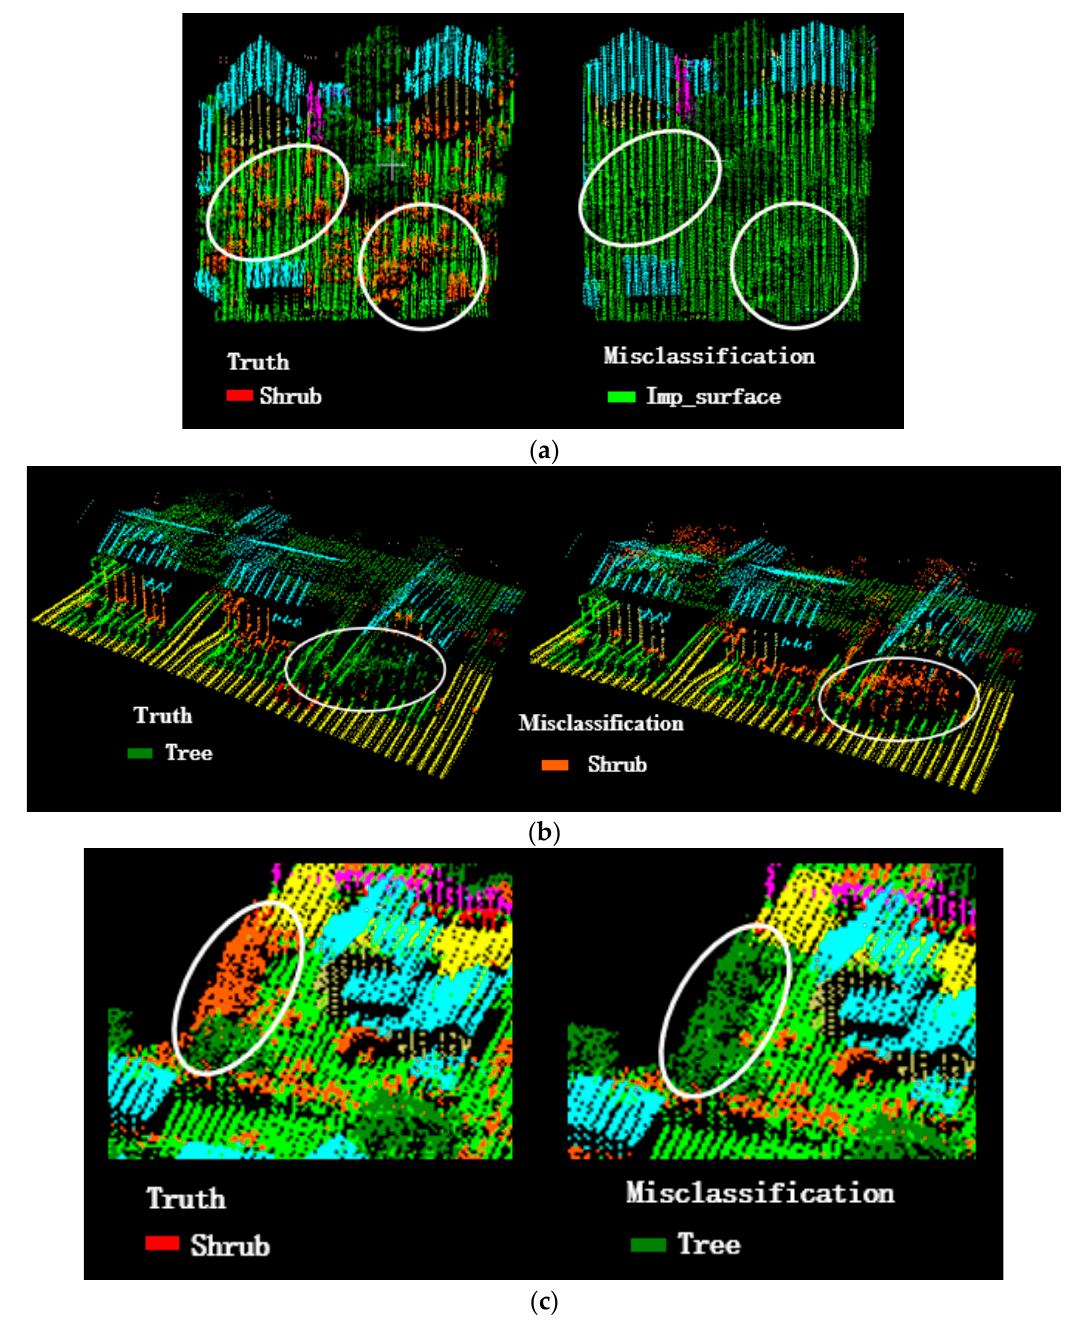
Figure 8. Details which were misclassified. ( a ) Zoomed-in image of the misclassification details of the model proposed in this paper on shrub; ( b , c ) zoomed-in details of the misclassification of the model proposed in this paper on tree.